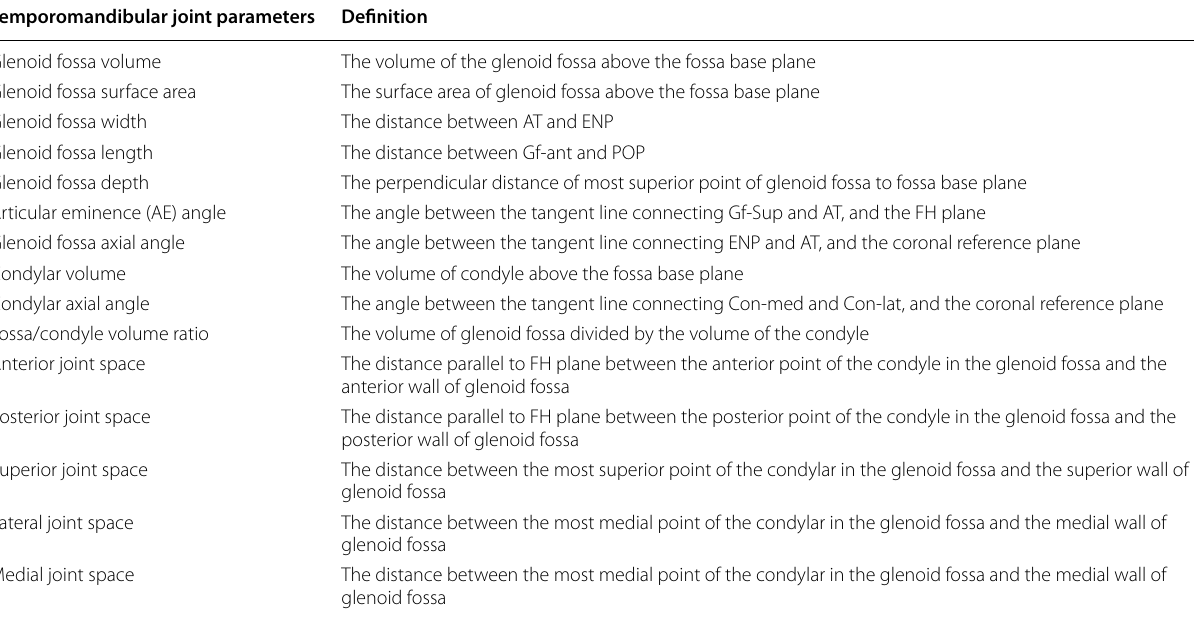
Table 2 Definitions of measurement of the temporomandibular joint parameters Temporomandibular joint parameters